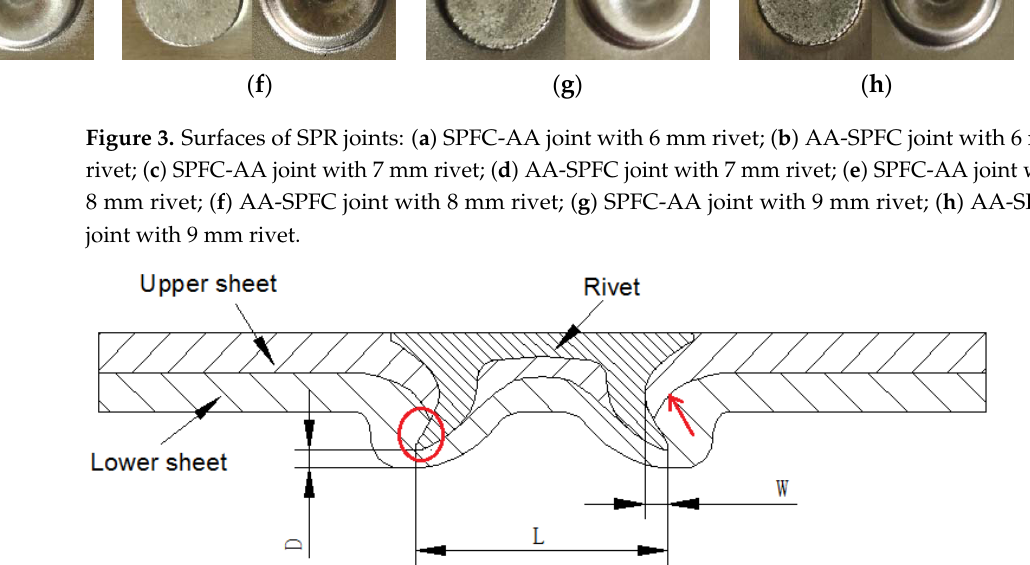
Figure 3. Surfaces of SPR joints: ( a ) SPFC-AA joint with 6 mm rivet; ( b ) AA-SPFC joint with 6 mm rivet; ( c ) SPFC-AA joint with 7 mm rivet; ( d ) AA-SPFC joint with 7 mm rivet; ( e ) SPFC-AA joint with 8 mm rivet; ( f ) AA-SPFC joint with 8 mm rivet; ( g ) SPFC-AA joint with 9 mm rivet; ( h ) AA-SPFC joint with 9 mm rivet.